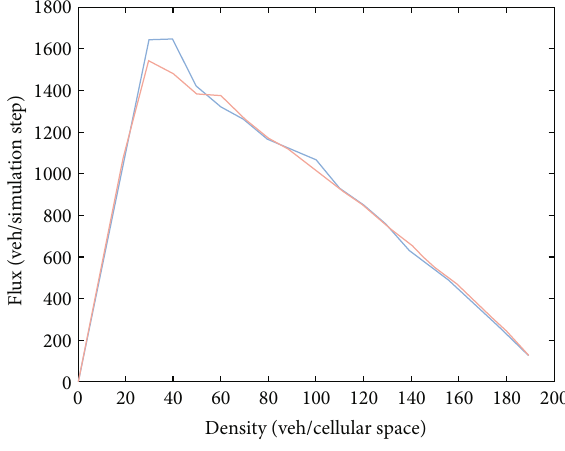
Figure 3: Flow-density fi